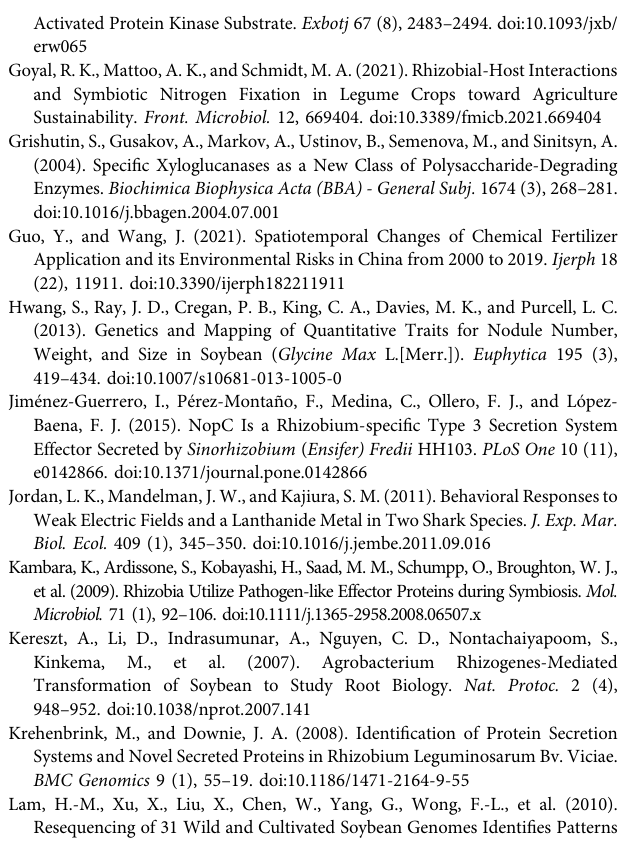
Supplementary Figure S2 | Relative expression levels of GmARP in transformed hairy roots. Data are means ±